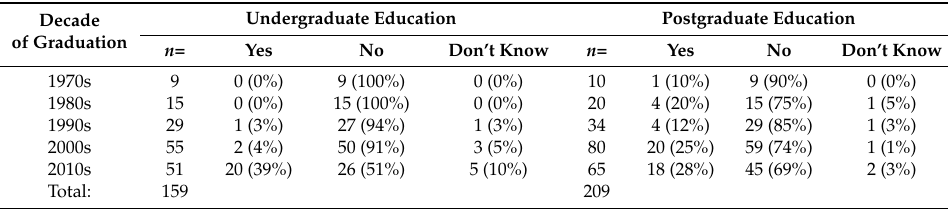
Table 2. The proportion of respondents who nominated that they had received undergraduate and/or postgraduate training on clinical audit by decade of graduation in a survey investigating the experiences and attitudes of UK farm animal clinicians towards clinical audit. Table includes responses from individuals answering questions both on year of graduation and undergraduate ( n = 159)/postgraduate education ( n = 209).